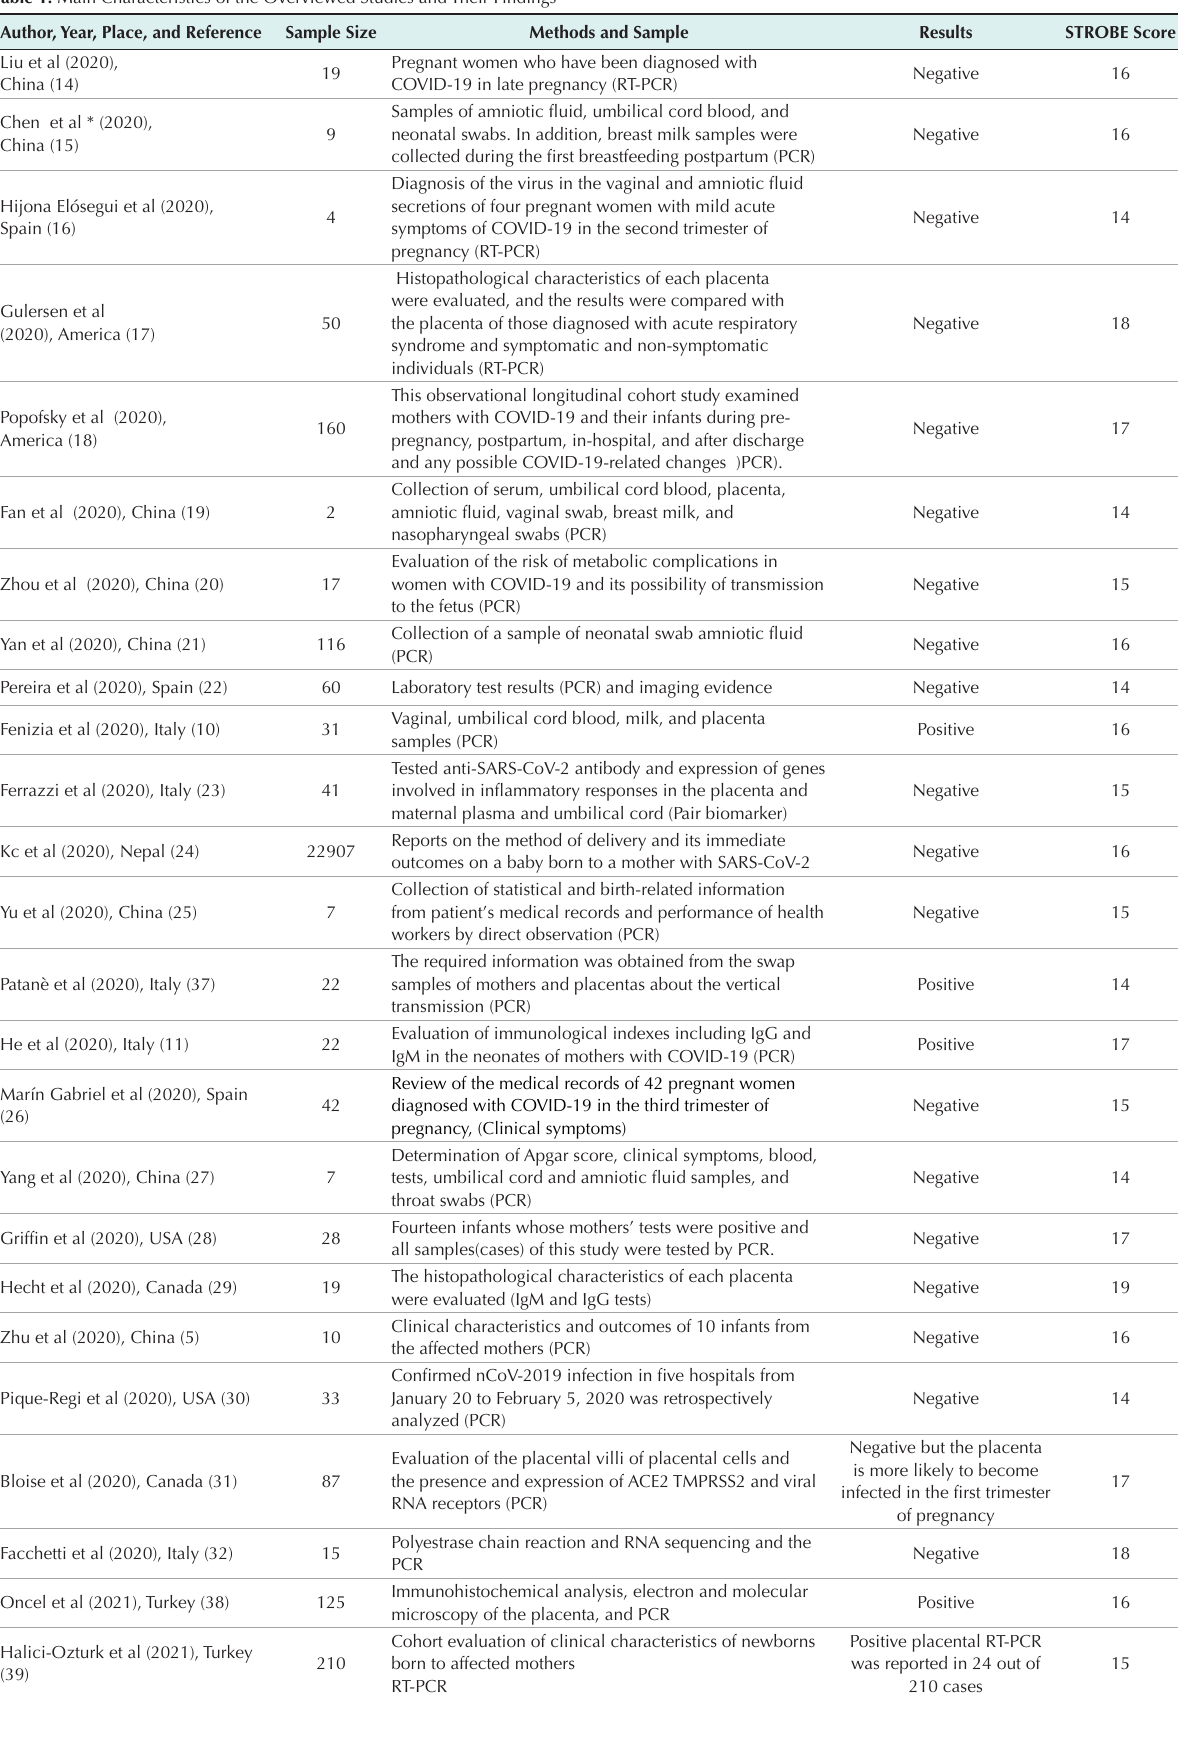
Table 1. Main Characteristics of the Overviewed Studies and Their Findings Author, Year, Place, and Reference Sample